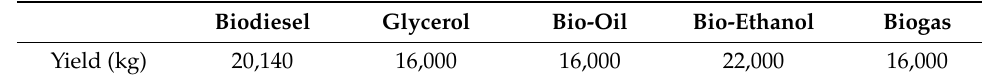
Figure 6. Optimal processing pathway in Scenario 2. Table 3. Optimization results in Scenario 2.